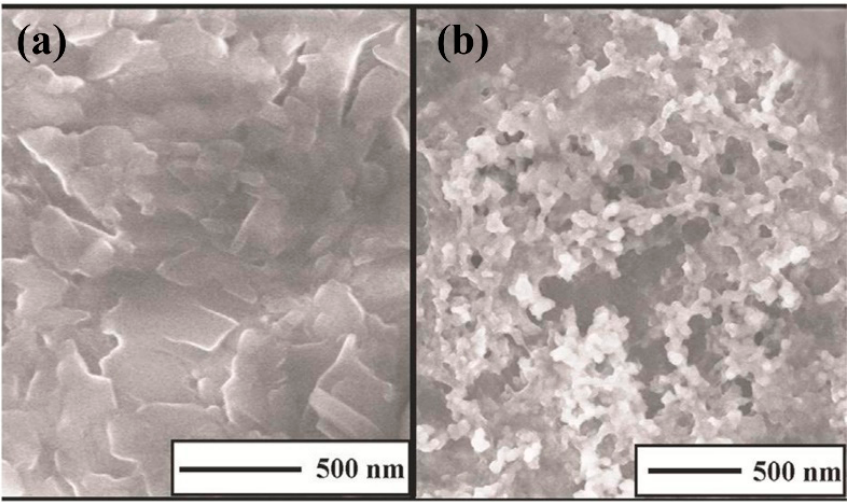
Figure 17. Micrograph of molecularly imprinted polymers/golf nanoparticles/glassy carbon elec- trodes (MIP/AuNPs/GCE) microstructure ( a ) before and ( b ) after metronidazole extraction. Modified with permission from [208]. Copyright 2015 Elsevier.